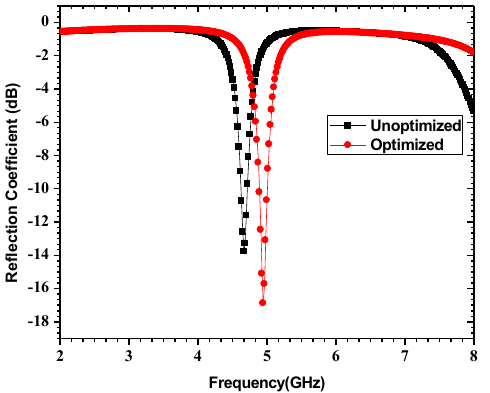
Figure 4: Comparative analysis of S11 of CTPA for side length